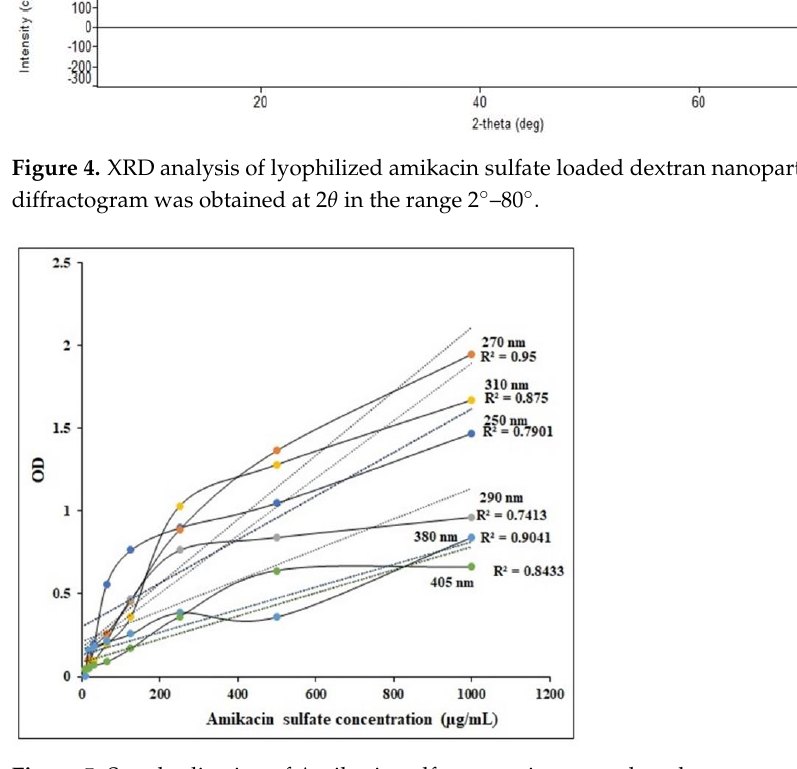
Figure 4. XRD analysis of lyophilized amikacin sulfate loaded dextran nanoparticles (LADNP). The diffractogram was obtained at 2 θ in the range 2°–80°.